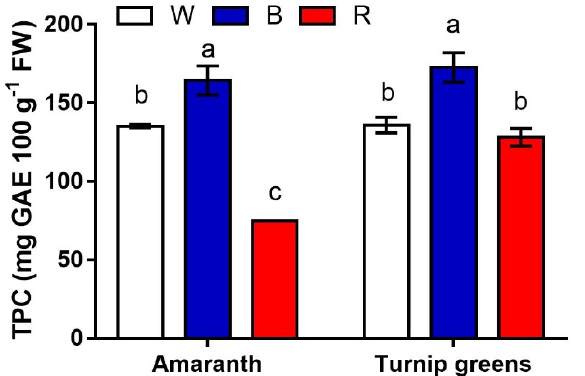
Figure 5. Interaction effect of species × light treatment (W = white, B = blue, R = red) on TPC (mg GAE·100 g − 1 FW) of microgreens. Data are means ± standard error ( n = 3). Three biological replicates were used for the analysis. Different letters indicate significance at p ≤ 0.05 according to Tukey’s test.